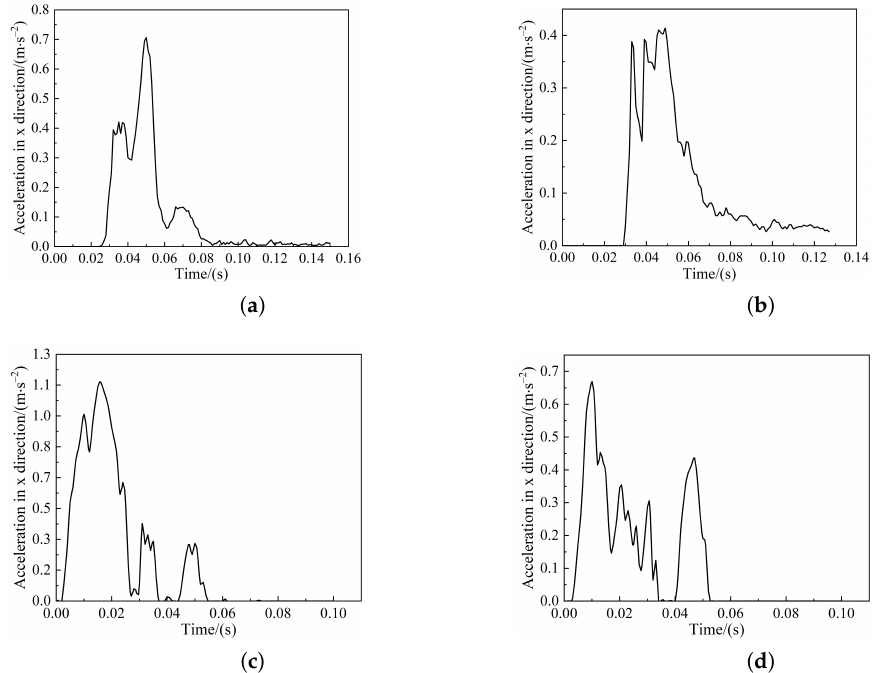
Figure 23. Acceleration curves of the train: ( a ) Pig head-on collision; ( b ) Pig offset collision; ( c ) Cow head-on collision; ( d ) Cow offset